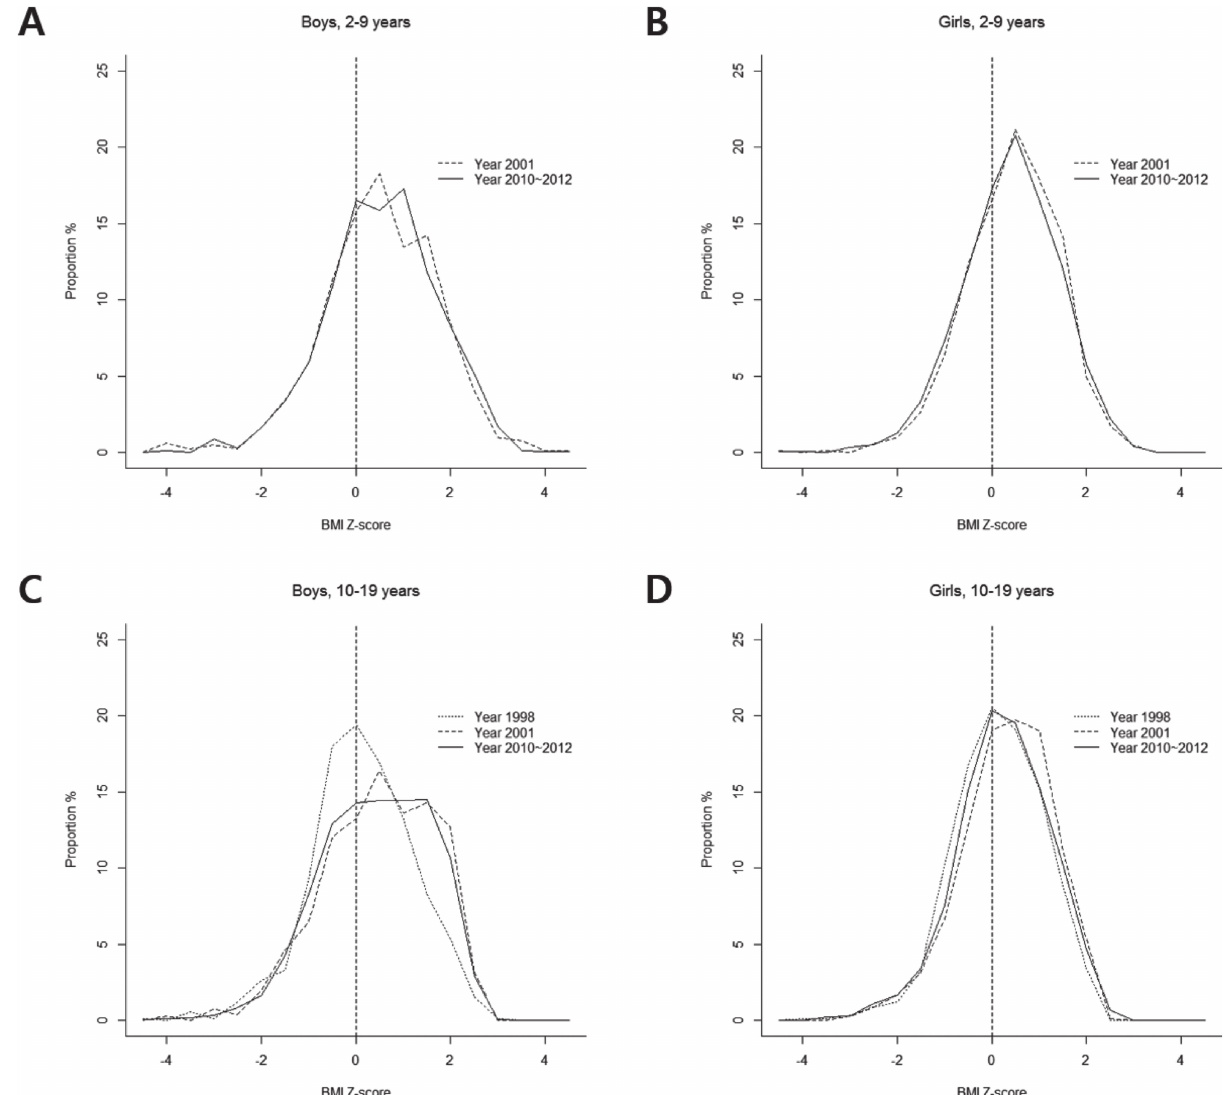
Figure. Changes in the distribution of body mass index (BMI) Z-scores among boys and girls, aged 2 – 9 between 2001 and 2010 – 2012, and aged 10 – 19 during 1998, 2001, and 2010 – 2012.